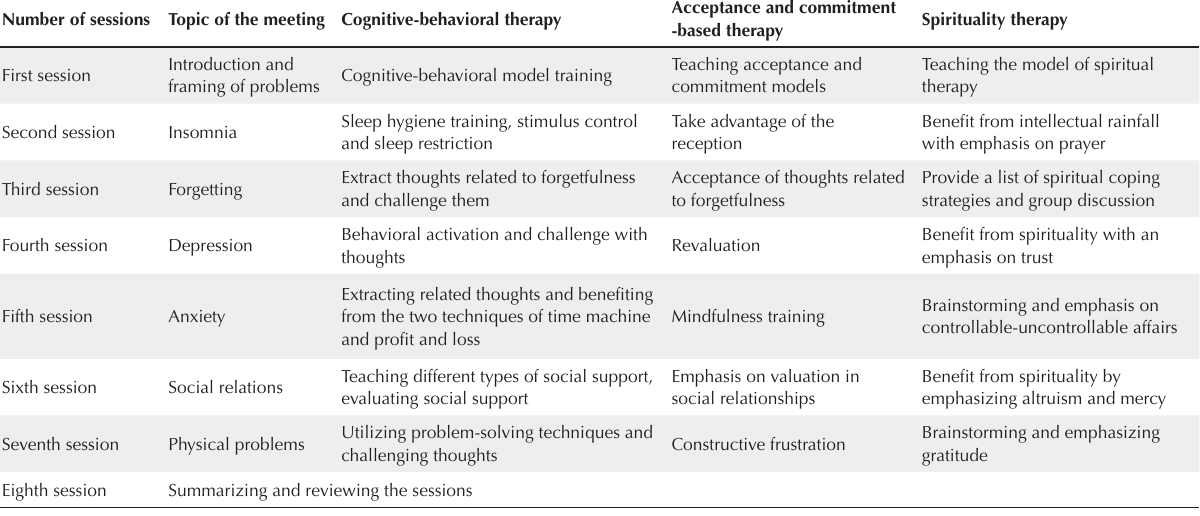
Acceptance and commitment -based therapy